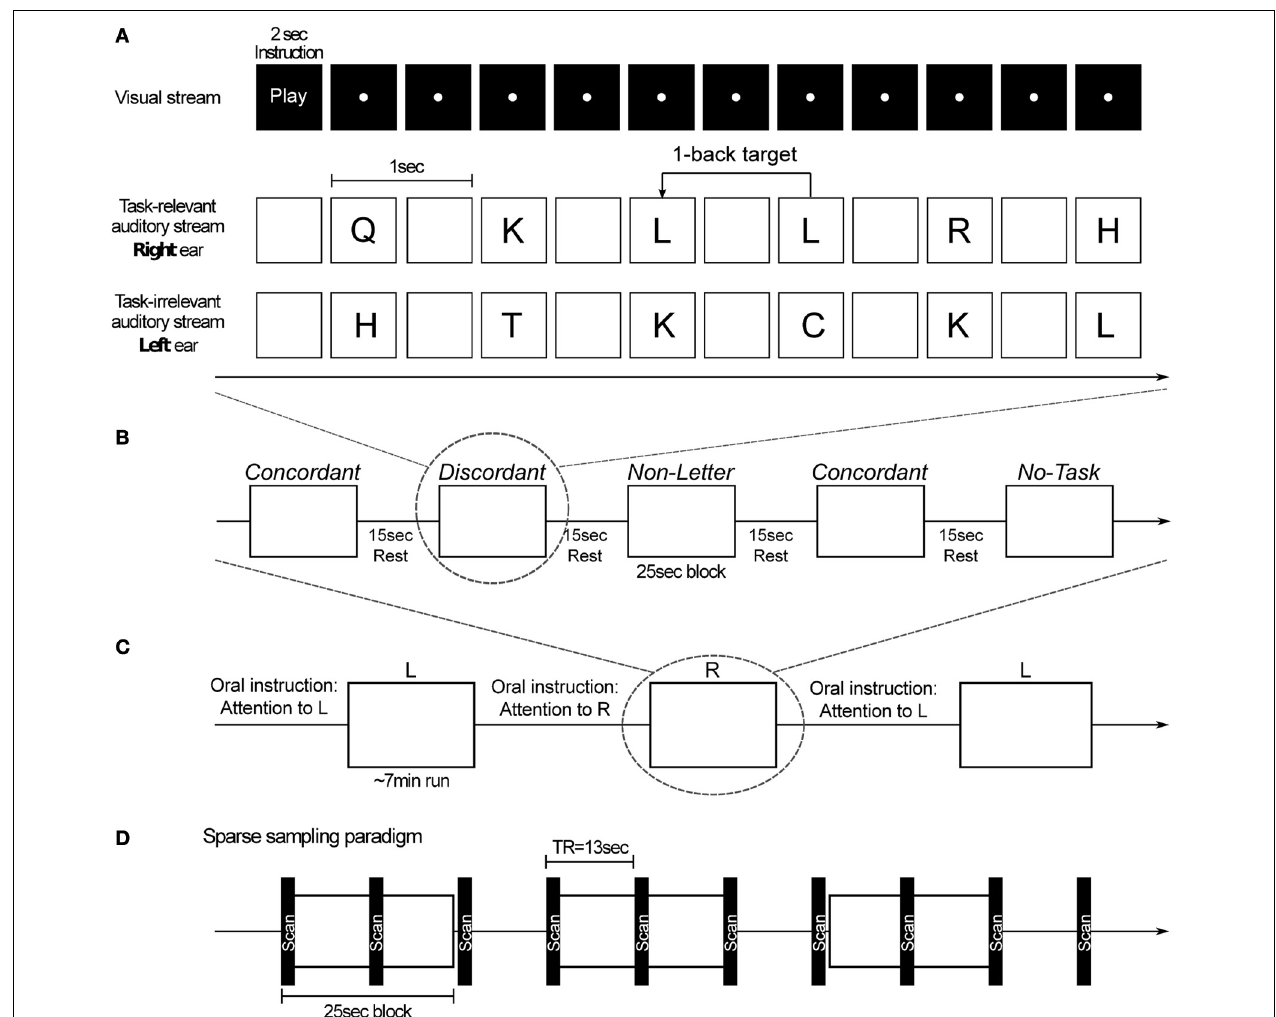
FIGURE 1 | (A) Example of the 1-back task for a discordant block. For this condition, a task-relevant stream and a task-irrelevant stream were presented. In the beginning of each block subjects are visually instructed to perform the task or to listen passively. For each presentation of the task-relevant stimulus a button must be pressed: one button if the stimulus is different from the previous one and a different button if it is